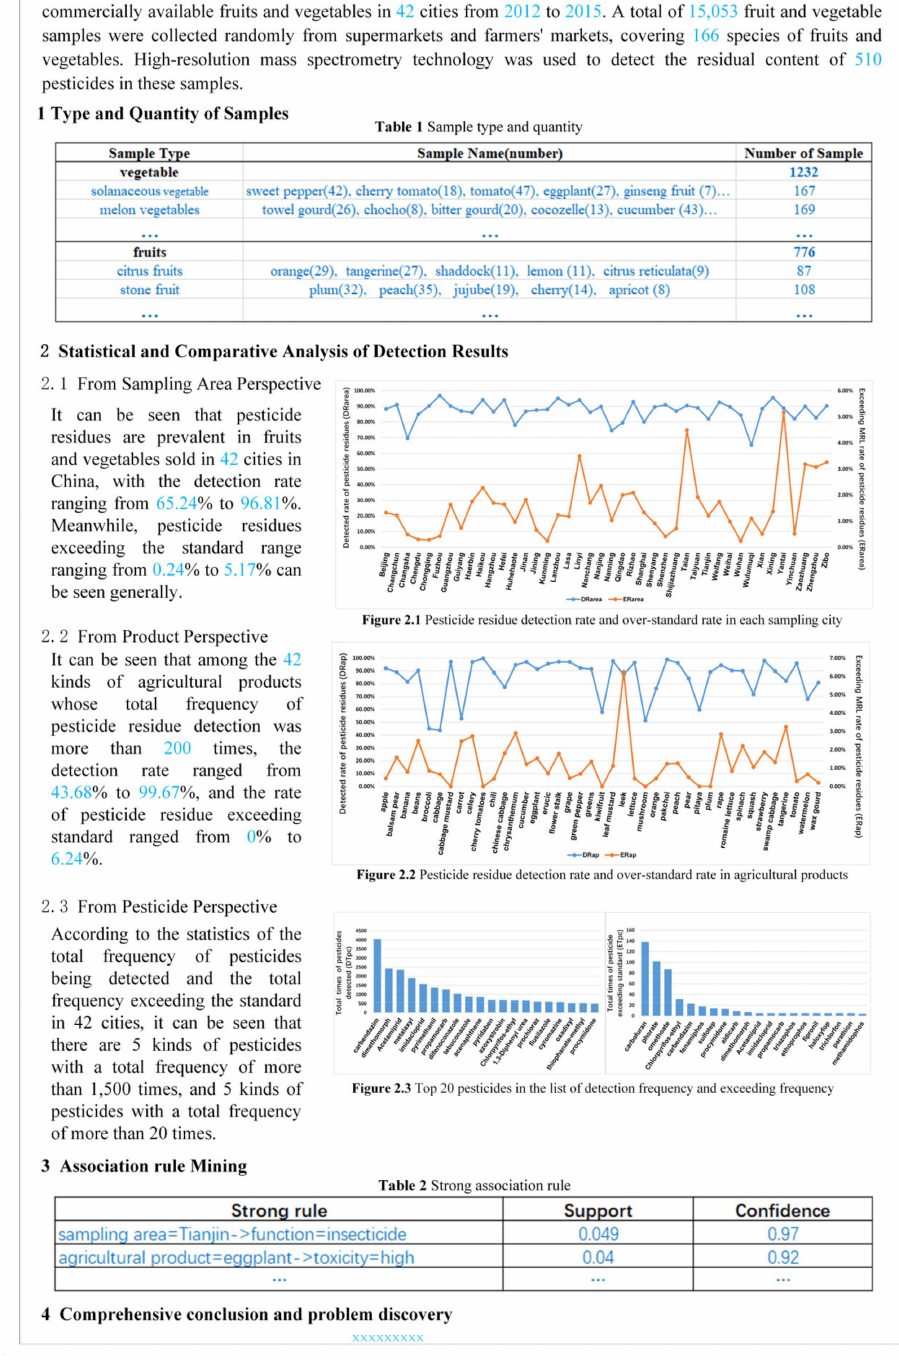
Figure 3. Template of analysis report of pesticide residue detection